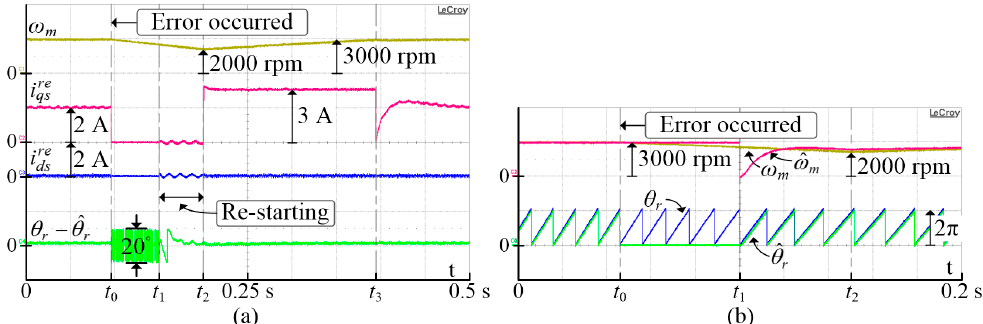
Figure 15. ( a ) Restarting of the motor from θ r = 0° with a positive speed under the rated load; ( b ) Amplified waveforms.